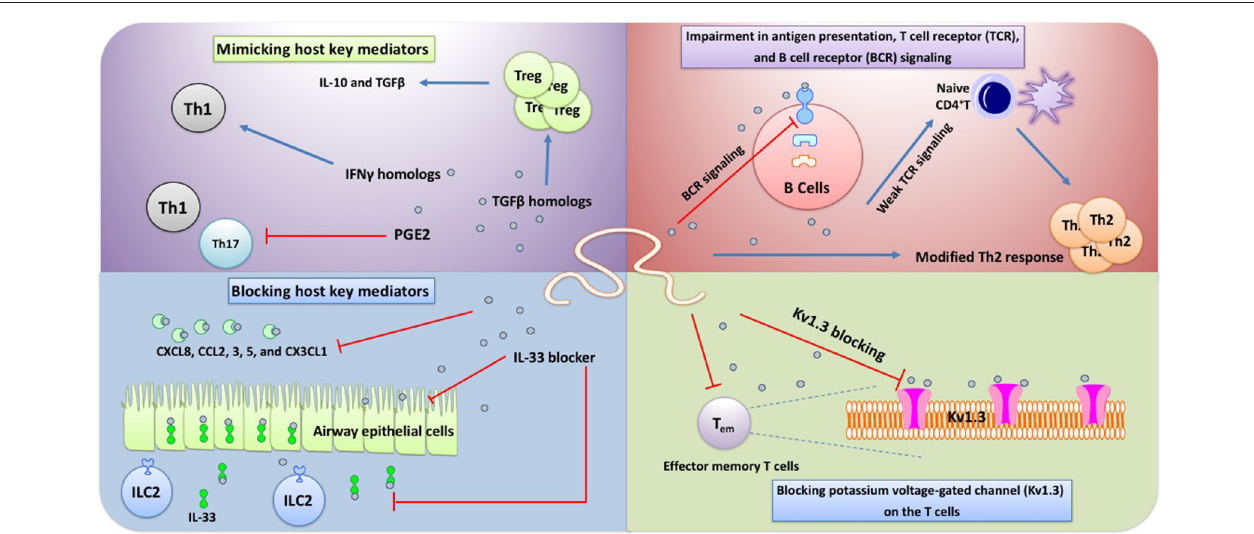
FIGURE 2 | Some HDPs has been shown to target non-PRRs sensors including Kv1.3 and TCRs on T cells. Blocking Kv1.3 can significantly decrease Th1 cell activity and proliferation. Also, presenting HDPs on the MHCII leads to induction a weak TCR signaling in naïve CD4T cells which corroborates Th2 differentiation. Of note, the main phenotype of Th2 response elicited by helminths and their products is “modified Th2” immunity in which IL-5, IL-13, eosinophlilia, and IgE are all downregulated, while IL-4, TGF β , and IL-10 are increased. BCR signaling has also been shown to be impaired by some HDPs which prevent B cell activation. HDPs have recently been more considered as magic components which are able to mimic or block several host key mediators which play an important role in immunosuppression and Th2 amplification,